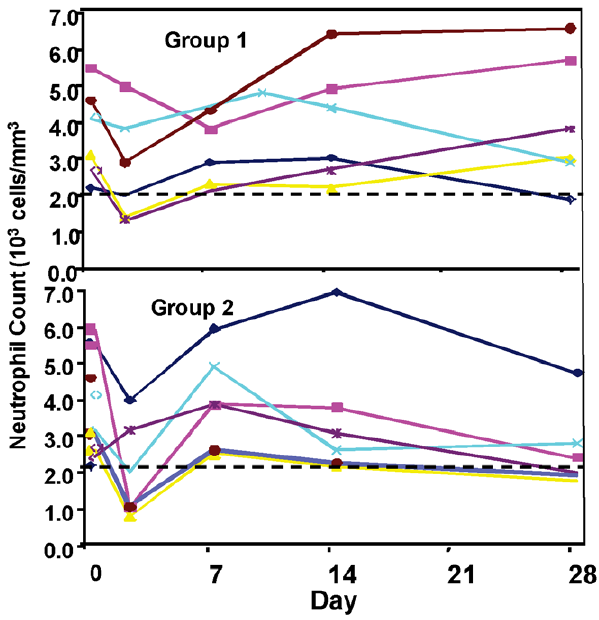
Figure 3. Neutrophil kinetics in Groups 1 and 2 after immunization. A fall in neutrophil count was observed in most volunteers at 2–3 days post-immunization with return to normal or near normal levels by day 7